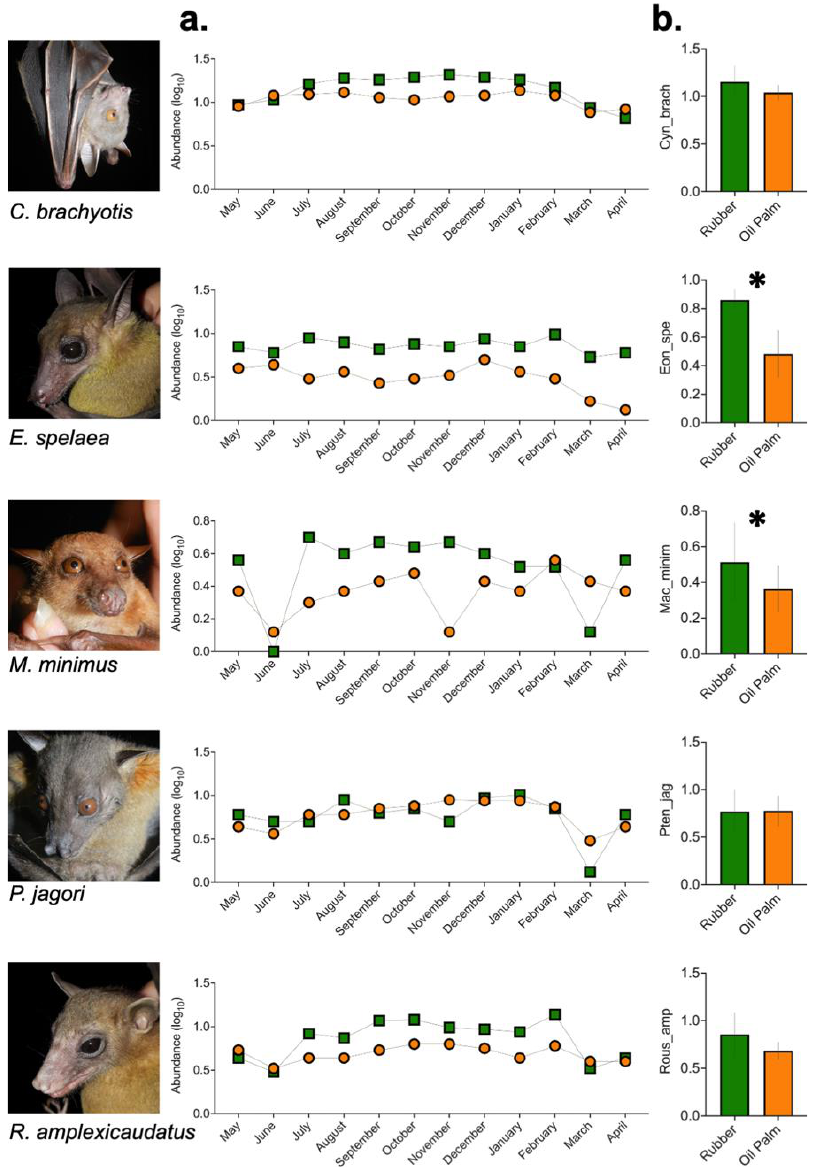
Figure 4. Species-specific comparison of seasonal fruit bat abundance across season ( a ) and between two plantations ( b ). The * indicates significance at p < 0.05.